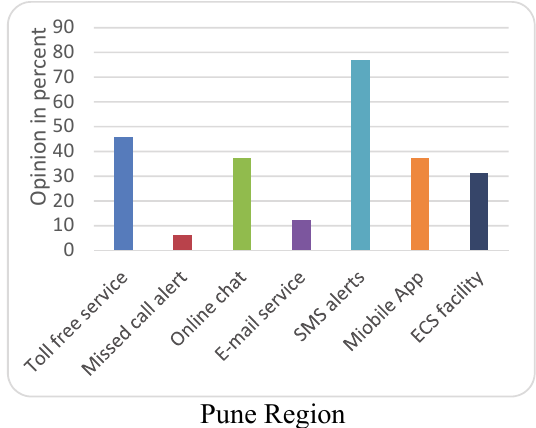
Fig. 4. Additional e-services expected by the